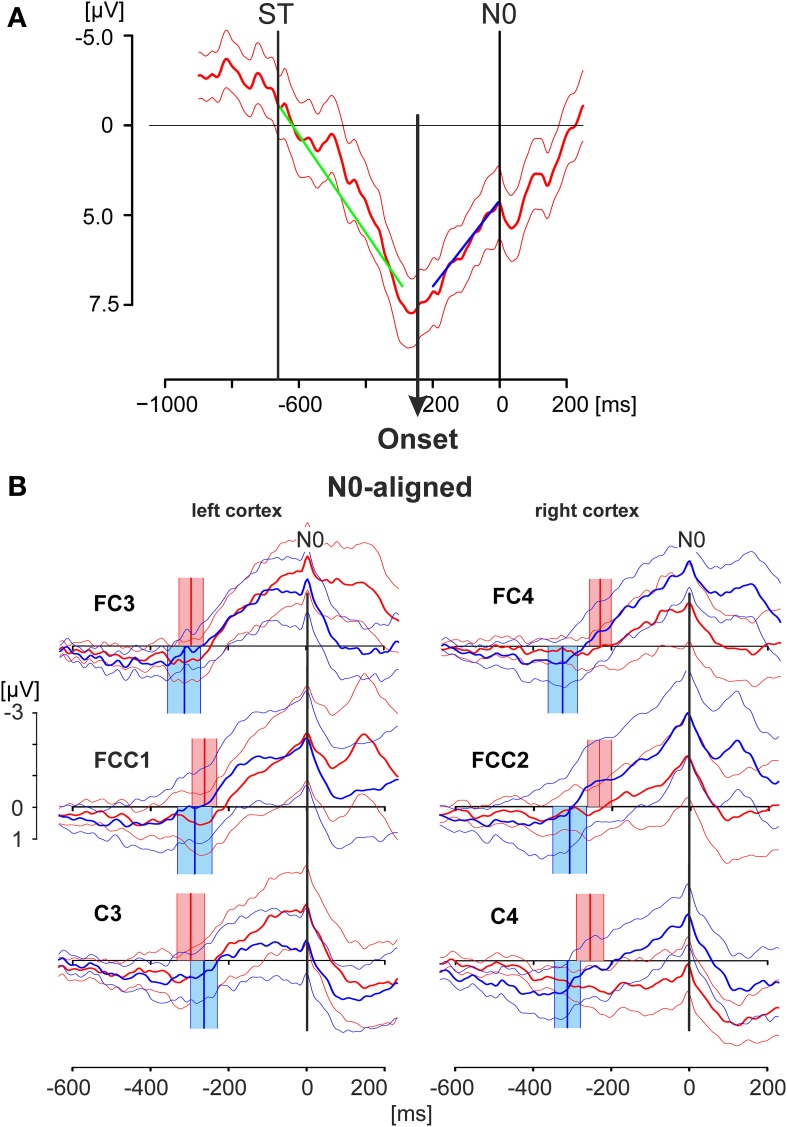
EEG activity patterns aligned to the negative peak N0. (A) Averaged EEG pattern (thick solid line; thin solid lines: 95% confidence limits) obtained from electrode position C3 of a single subject during match-trials showing the method employed to detect the Onset of the increasing negativity terminating in N0. The onset has been calculated by a regression model describing the data with two different linear splines. The time window starting from the stimulus onset (ST) and terminating at the N0 peak was divided in two intervals at any time point inside the time window. Linear regression analyses were preformed for both intervals (regression lies green and blue). The onset of the increasing negativity was determined in a least-squares setting by that point in time at which the residues of both regressions resulted in a minimal value (see Material and Methods Section). (B) The grand averaged EEG activities as displayed in Figure 3 are shown, here aligned to the time of N0. The thick solid lines represent the averaged responses whereas the thin lines indicate the 95% confidence limits of the group mean. Red lines represent responses during match-trials, blue lines those of mismatch-trials. The red and blue blocks cover the time range (95% confidence limits: solid thin lines) of the times of onset (mean values: solid thick lines) as shown in the example in (A) for match and mismatch-trials, respectively. Data in (A) are shown for the period −1000 to +200 ms and are scaled from −5 to +7.5 μV. Data in (B) are shown for the period −600 to +200 ms and are scaled equally from −3 to +1 μV.